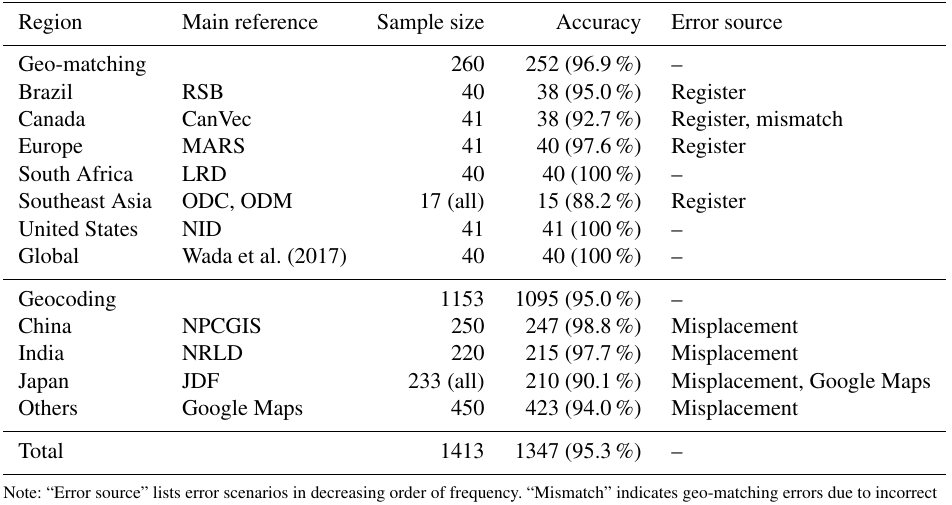
Table 4. Validation statistics for GeoDAR